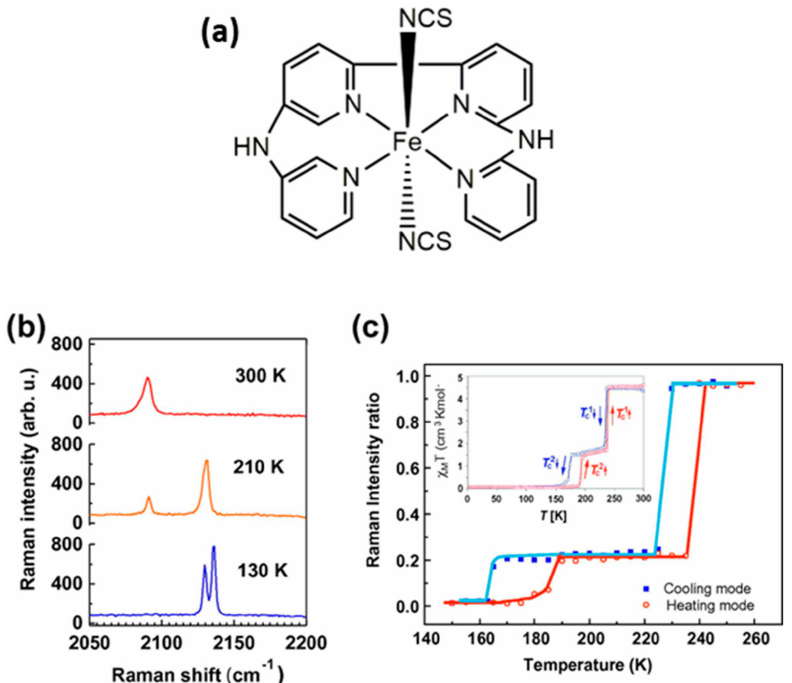
Figure 9. ( a ) Structural drawing of [Fe(bapbpy)(NCS) 2 ] (complex 13 ). ( b ) Raman spectra in the region 2050–2200 cm − 1 of [Fe(bapbpy)(NCS) 2 ] at 130, 210, and 300 K. ( c ) Raman intensity ratio as a function of temperature. ( b , c ) are reprinted with permission from ref. [59], copyright 2010,